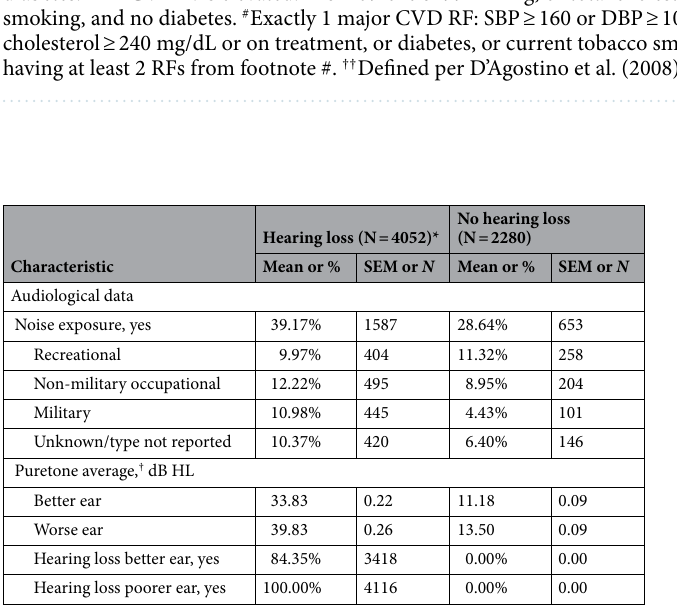
Table 1. Patient demographic and cardiovascular characteristics by hearing status. P-values from Chi-square tests (categorical variables) or t tests (continuous variables). BMI body mass index, DBP diastolic blood pressure, PTA pure-tone average SBP systolic blood pressure, SEM standard error of the mean. *Defined as PTA 0.5,1,2,4 > 20 dB HL in the worse ear. † One patient was excluded from logistic regression models due to missing BP group status. ‡ N for hearing loss and normal hearing groups, respectively. Estimated average glucose: N = 2944, 1465; Glucose tolerance fasting: N = 7, 54; Glucose serum/plasma: N = 3824, 2113; Glucose random serum/plasma: N = 3251, 1576; Framingham Risk Score: N = 5452 overall. § All CVD RFs optimal: BP < 120 and < 80 mmHg, total cholesterol < 180 mg/dL, not currently smoking, and no diabetes. ‖ ≥ 1 CVD RF not optimal: BP 120–139 or 80–89 mmHg or total cholesterol 180–199 mg/dL, not currently smoking, and no diabetes. ¶ ≥ 1 CVD RFs elevated: 140–159 or 90–99 mmHg, or total cholesterol 200–239 mg/dL, not currently